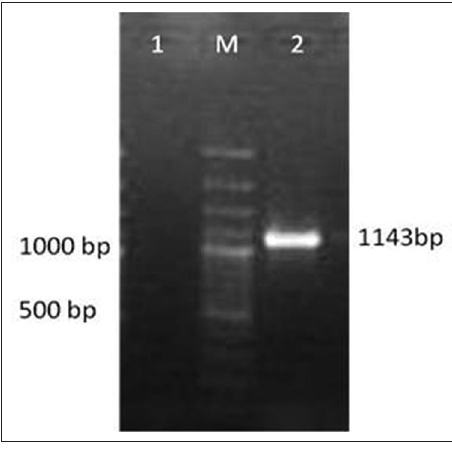
Figure-2: Polymerase chain reaction amplification of nagH gene of Clostridium chauvoei: Lane M: 100 bp DNA Ladder, Lane 1: Negative control, Lane 2: nagH gene.